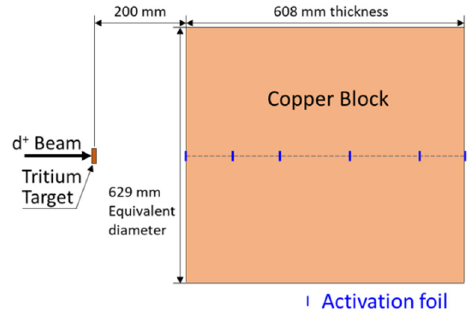
Fig. 4. Computational geometry model of FNS copper benchmark experiment.